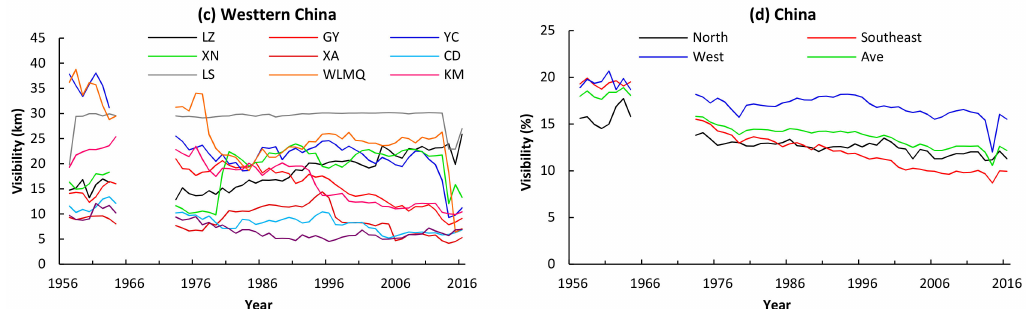
Figure 2. Variation of annual average visibility (km) of PCCs in ( a ) northern China, ( b )